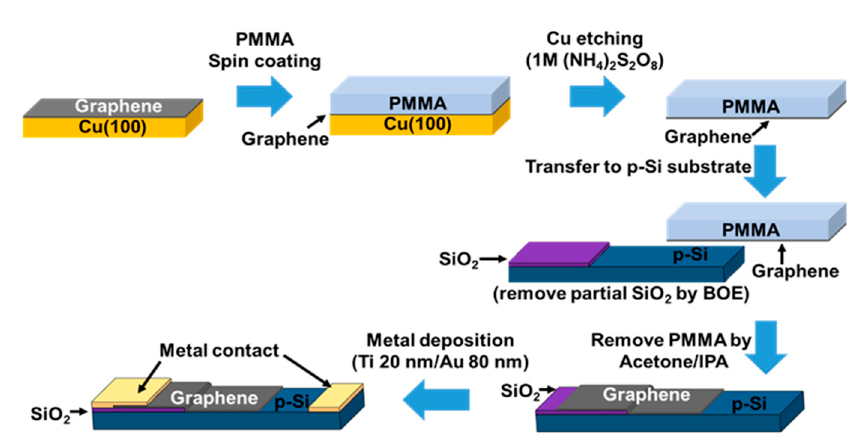
Figure 2. Process flow diagram of the camphor-based chemical vaper deposition (CVD) bilayer graphene/p-Si photodetector (PD) that was fabricated.